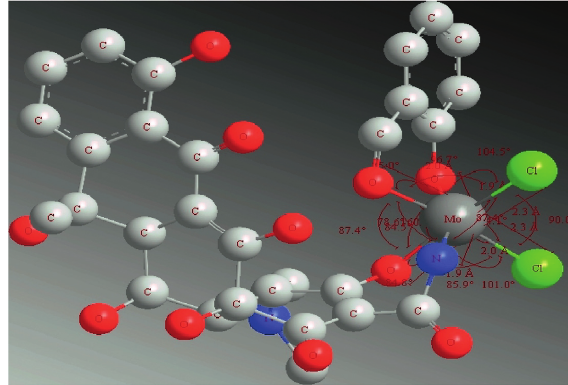
Figure 7: Optimized geometry of the Mo-OTC/Sal